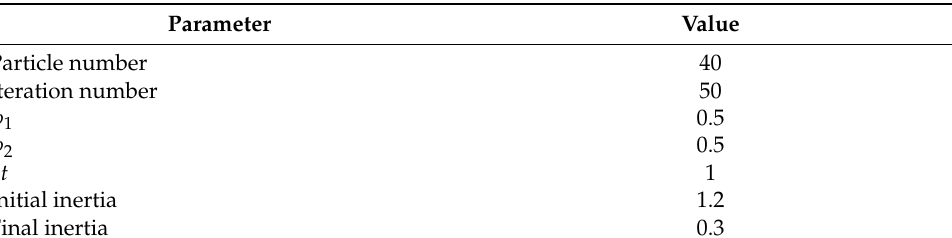
Table 4. Particle swarm optimization (PSO) optimizer parameter set for the first study case.